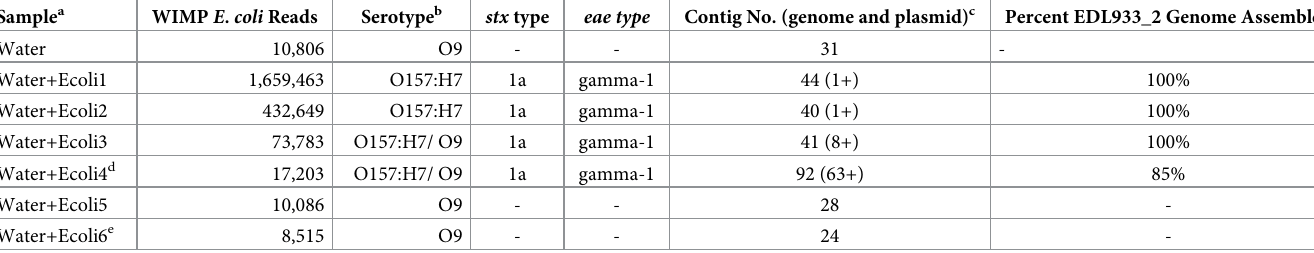
Table 3. Virulence of the Flye assemblies obtained with the WIMP E . coli extracted reads. Sample